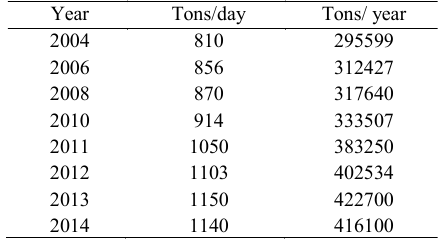
Table 1: Solid waste generated in Isfahan from 2004 to 2014